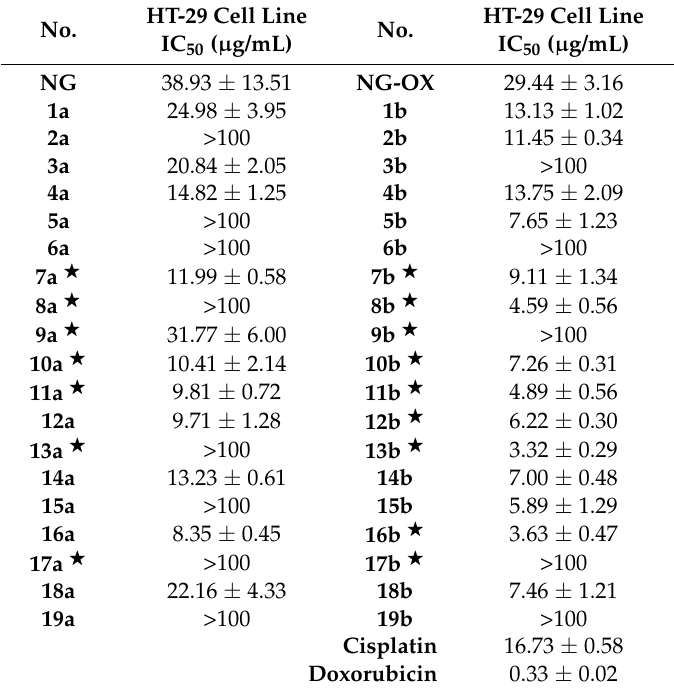
Table 3. Anticancer activity of the O -alkyl derivatives of naringenin and their oximes. HT-29 Cell No.